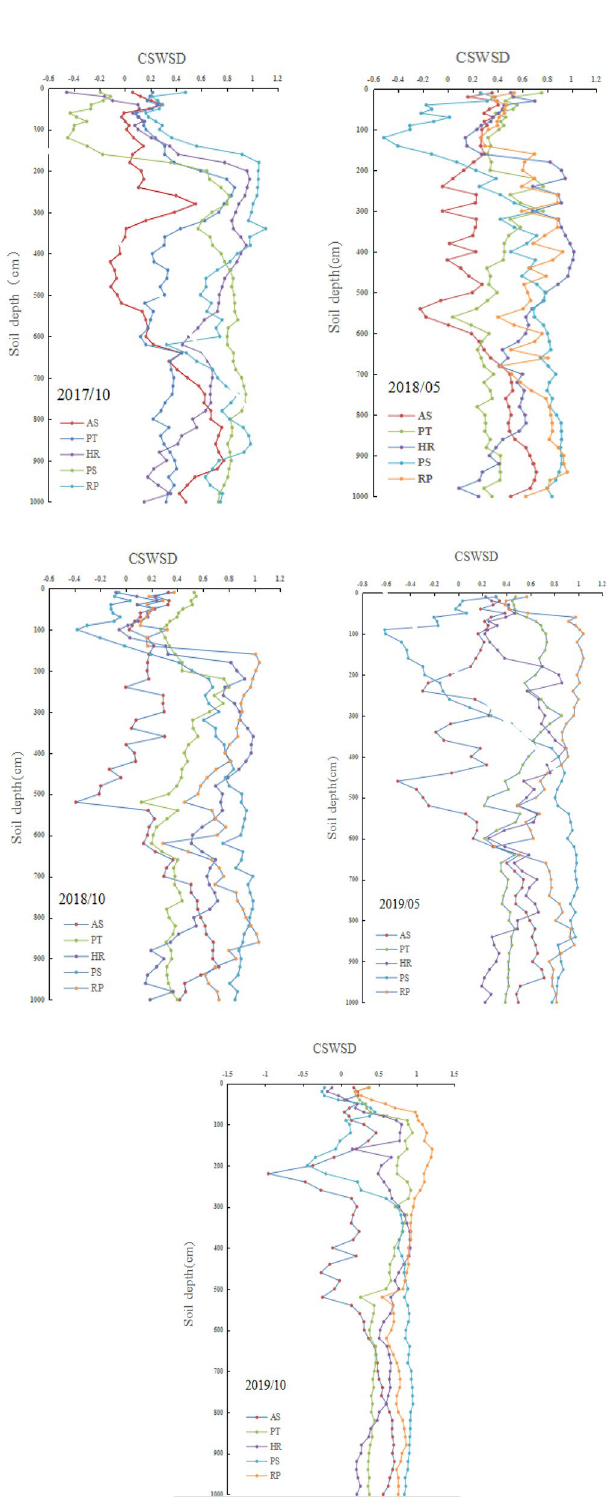
Figure 3. The comparison of soil moisture storage deficit of different vegetation